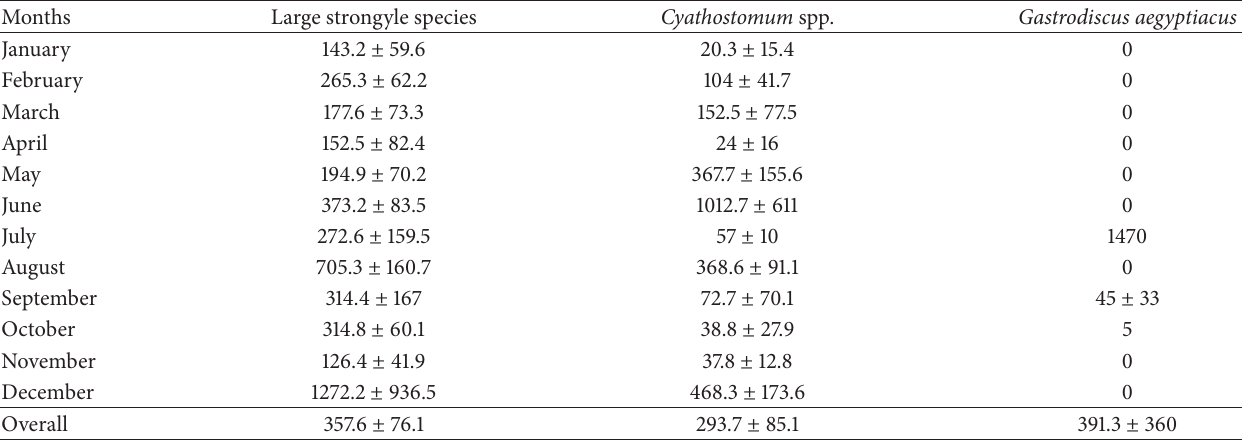
(60%), Strongylus equinus (22%), and Strongylus edentatus (18%), cyathostomins spp. (72.3%), Gastrodiscus aegyptiacus (4.5%), and Oxyuris equi